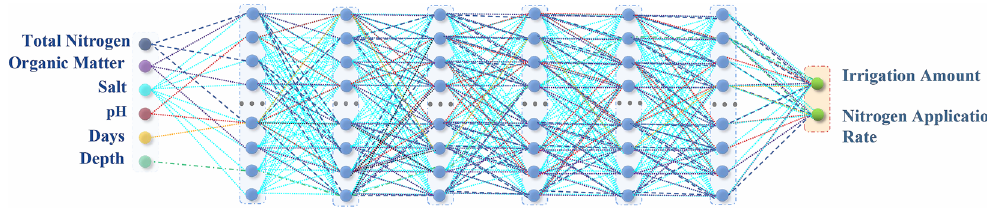
Figure 5. Schematic diagram of the preference connection structures of the preference neural networks. The depth of the network detailed in the figure only illustrates the preference connection structure (for a better demonstration), and does not indicate the depth of the PNN used in the experiment.